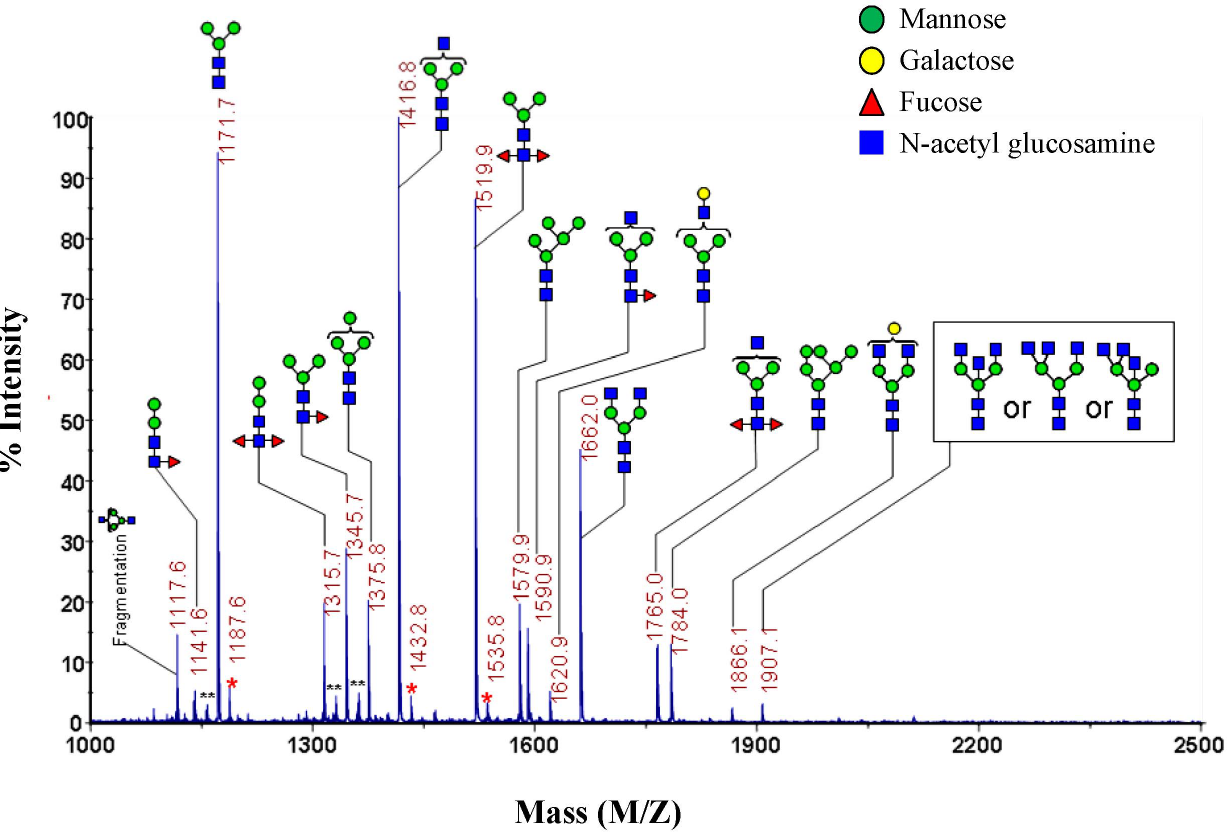
Figure 1. Full MALDI-TOF mass spectrum of permethylated N-linked glycans from Blag2 . N-linked glycans were prepared from purified natural Bla g2 glycoprotein and analyzed by MALDI-TOF mass spectrum. Glycan compositions were assigned by comparison of measured m/z values with m/z values calculated based on putative composition of permethylated glycans. X axis: mass to charge ratio (m/z). Green circle: Mannose; yellow circle: galactose; red triangle: fucose; and blue square: N-acetyl glucosamine. Y axis: signal intensity of the ions. **is undermethylated glycans. *is unknown peaks. fibrocytes in response to Bla g 2. After exposure to Bla g 2 (10 m g/ ml), fibrocytes were activated at various times (15 min to 1 h, Fig. 6A) as determined by the levels of phosphorylated p65, p38,